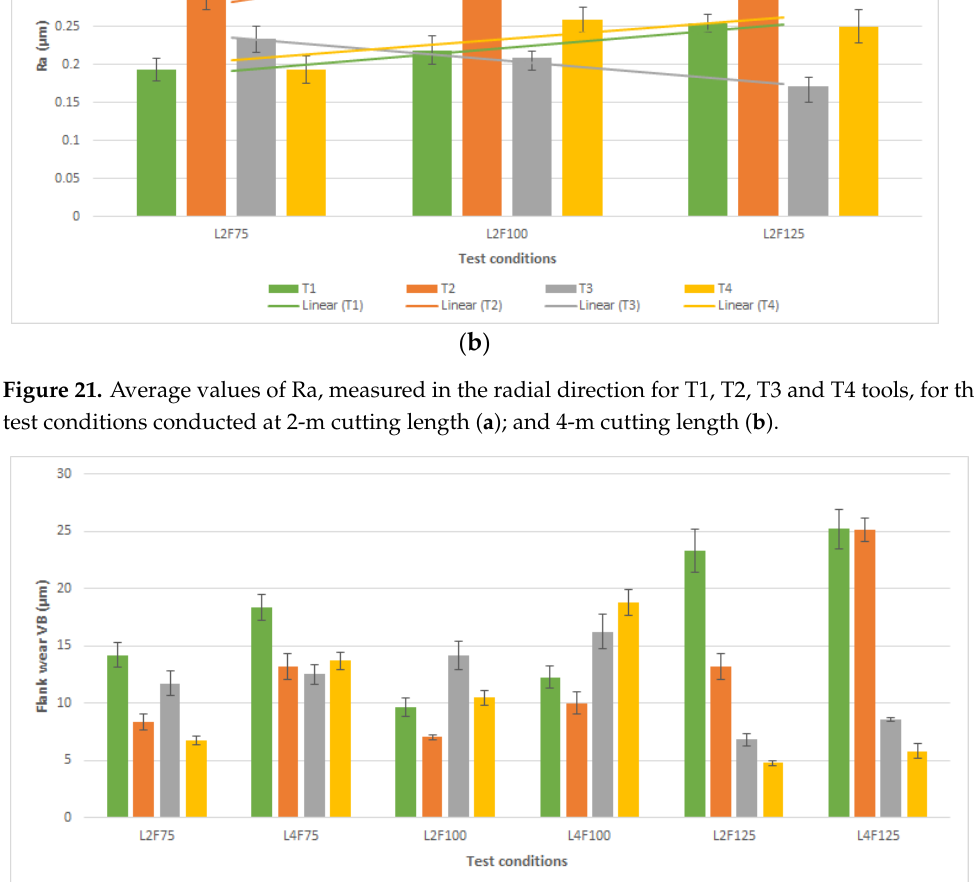
Figure 22. Average values of VB, measured on the clearance faces of the T1, T2, T3 and T4 tools, for all the different test conditions.